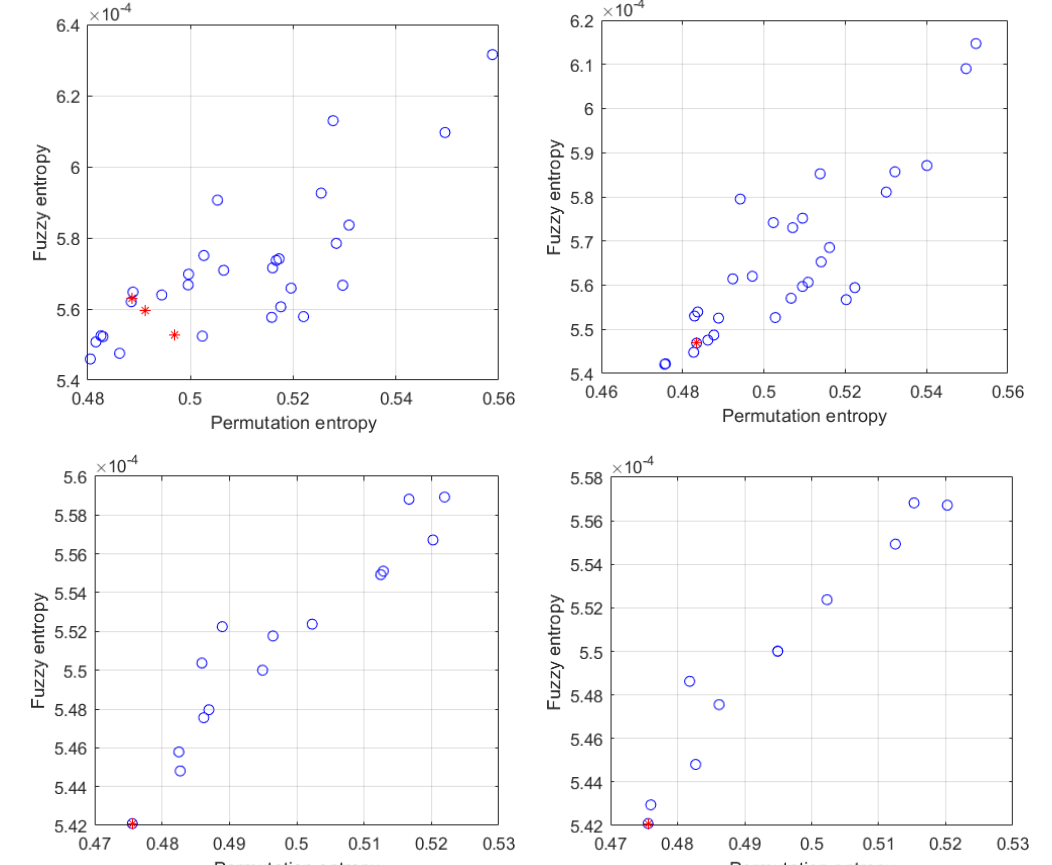
Figure 11. The result of particle convergence during the iterative